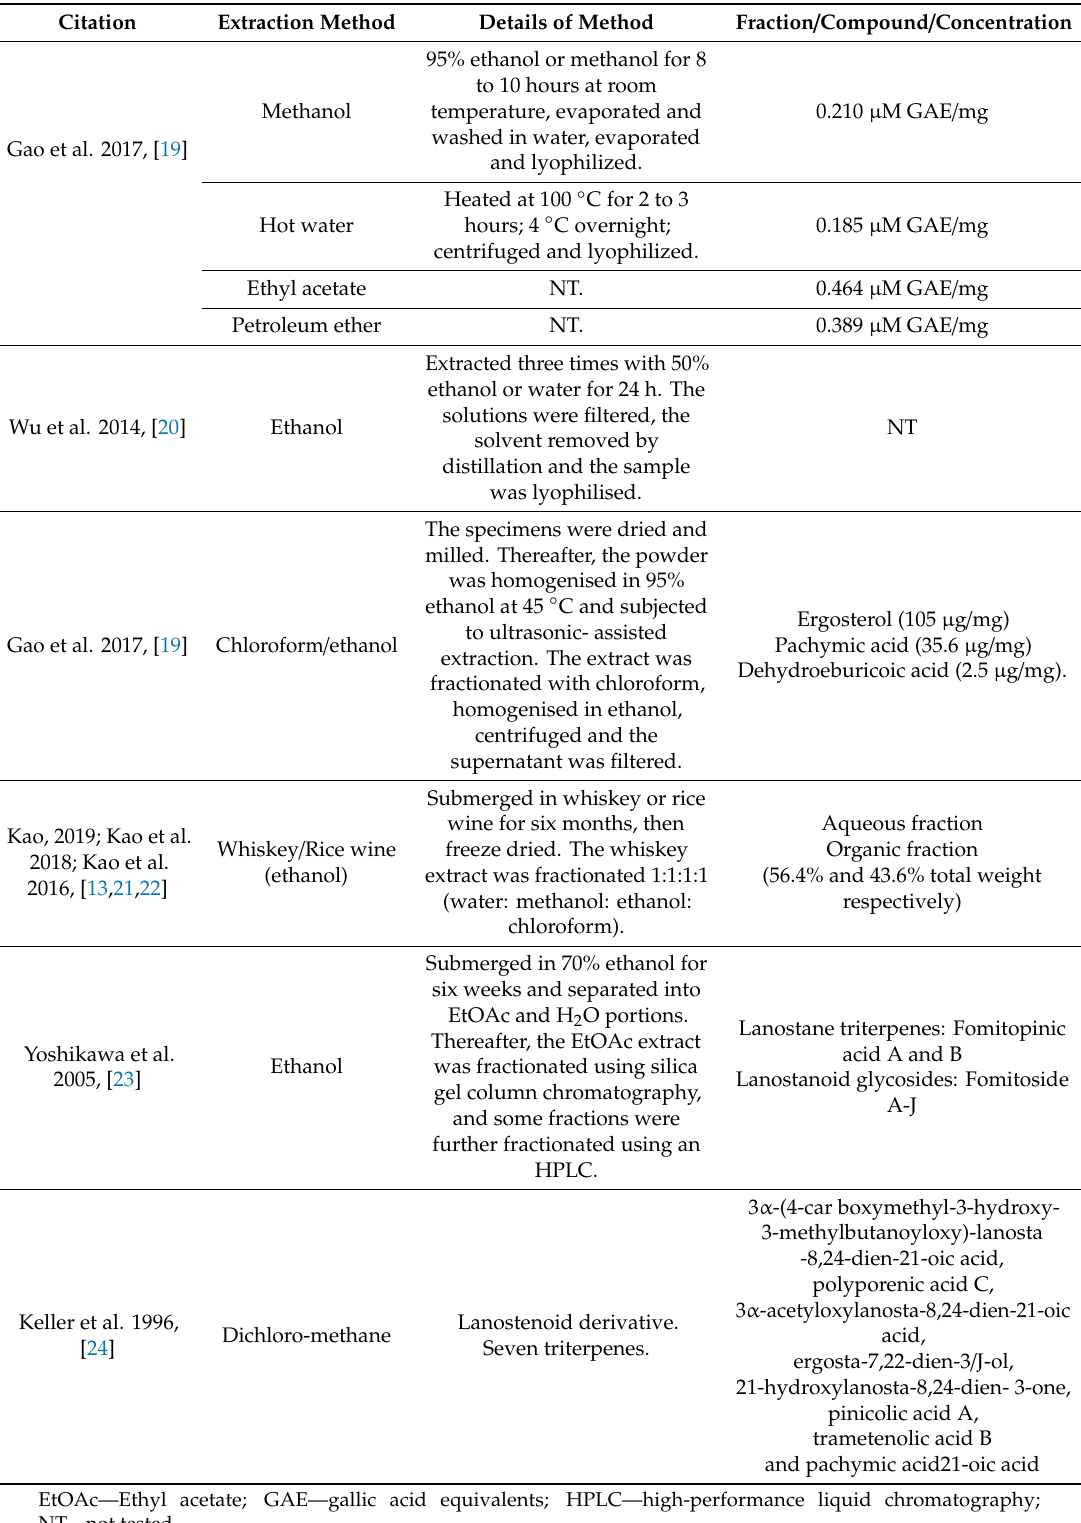
Table 1. Extraction method and fraction or compound detected from F. pinicola